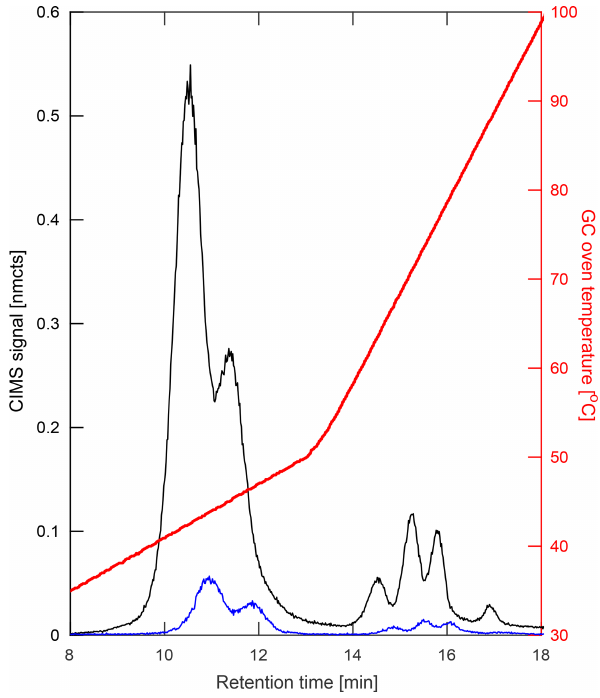
Figure 3. Comparison of chromatograms of the IHN isomers ob- tained from the two different GC analysis modes in which the same amount of analyte is collected on the column but is directed into ei- ther the ion source (black) or flow tube (blue). GCs that are directed into the ion source result in approximately a 10-fold signal increase compared to flow tube GC analysis. In addition, compounds ana- lyzed via the ion source typically elute at lower temperatures com- pared to flow tube analysis, an advantage for sampling fragile mul- tifunctional